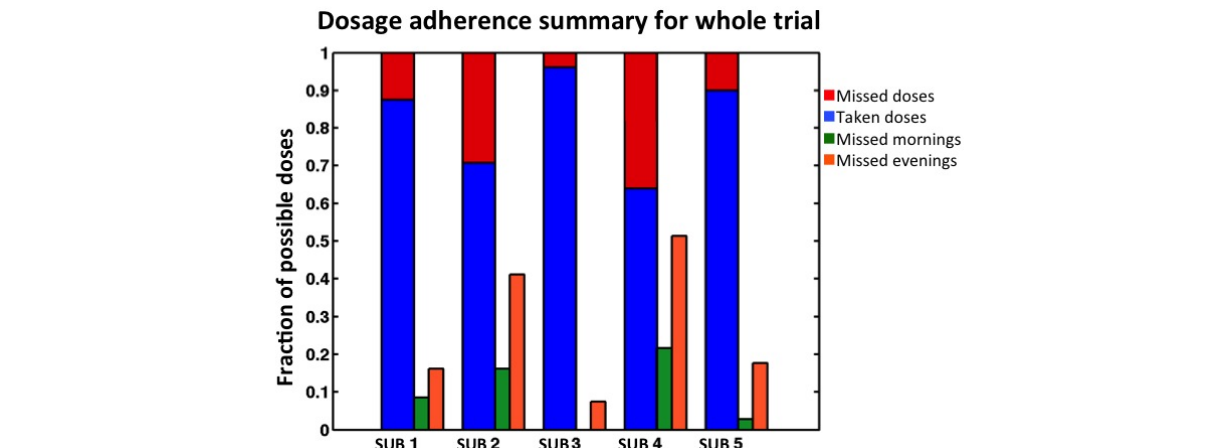
Figure 4. Dosage adherence summary for whole trial.